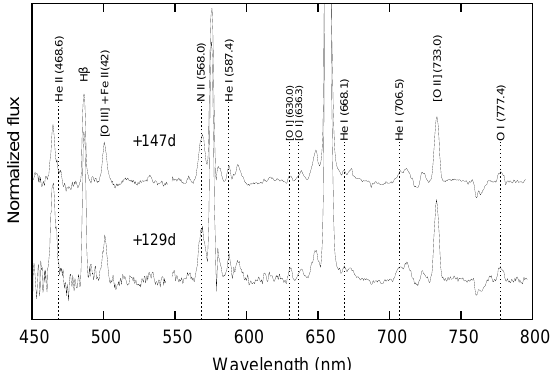
Figure 4: The spectra of V5587 Sgr in nebular phase(+129 days and +147 days after its